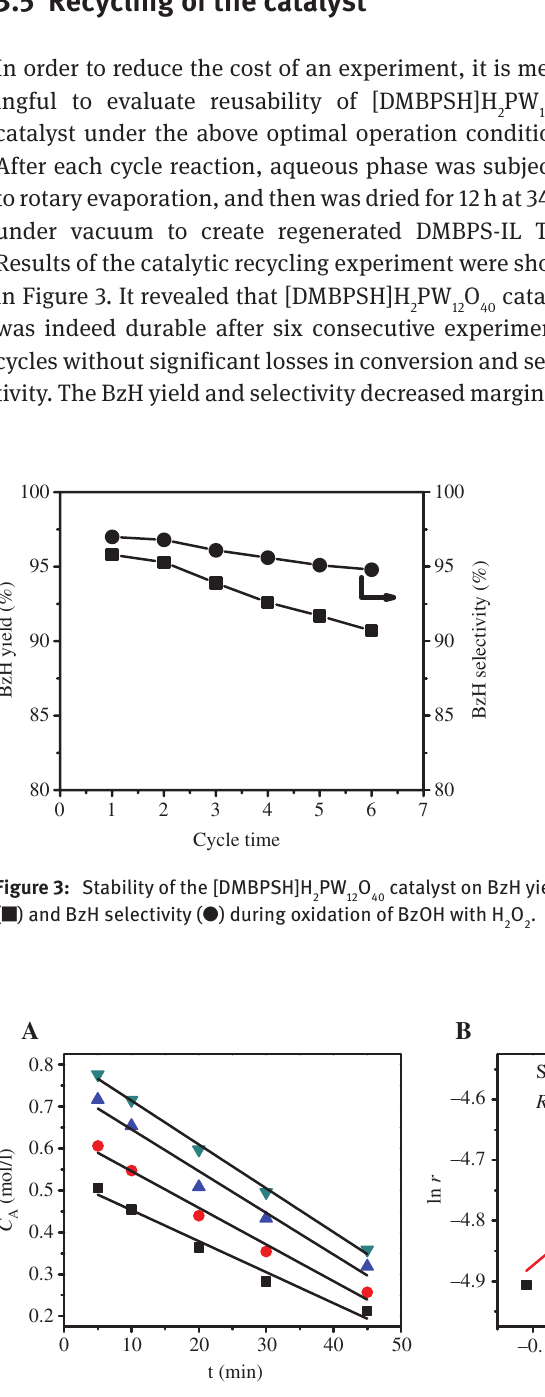
Figure 4: (A) Variations of BzOH concentration ( C and 0.89 (■) mol/l, and (B) log-log plot of initial oxidation rate versus initial C concentration 2.18 mol/l; BzH concentration 0 mol/l; and amount of catalyst 7.47